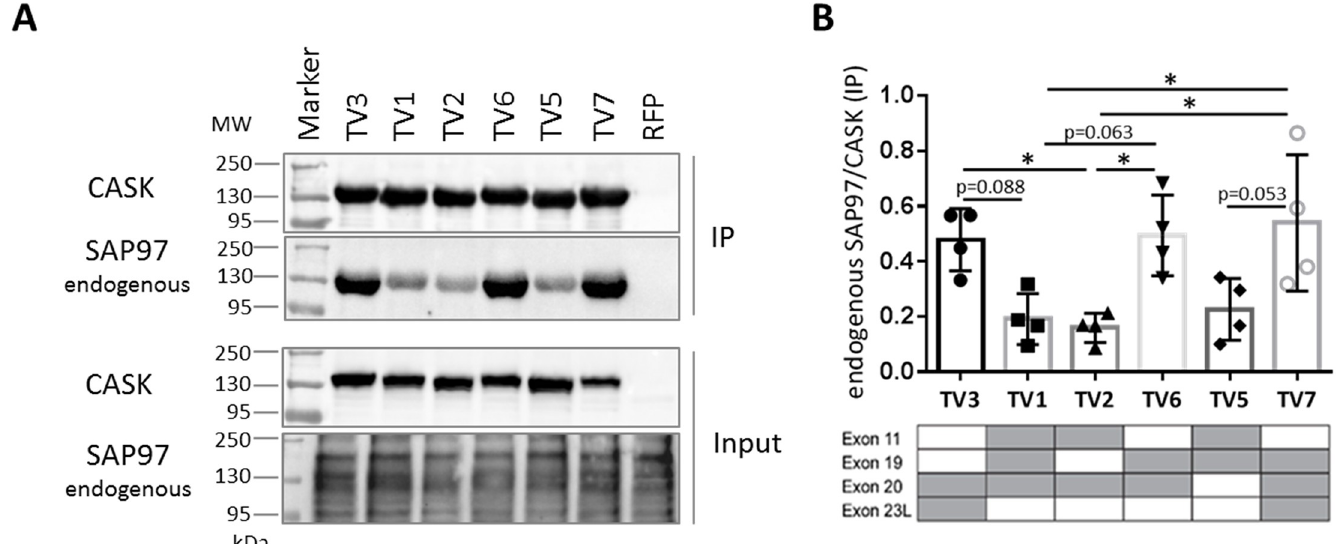
Fig 8. Interaction of CASK variants with endogenous SAP97. A. 293-T cells transfected with mRFP-tagged CASK variants, as shown in Fig 3, were subjected to cell lysis and immunoprecipitation of mRFP-tagged proteins. In addition to staining for CASK, input and precipitate samples were analyzed using anti-SAP97. B: Quantification of results, as the ratio of SAP97/CASK signal ration in IP samples. � , p < 0.05; one-way ANOVA with Tukey’s multiple comparisons test, n = 4.